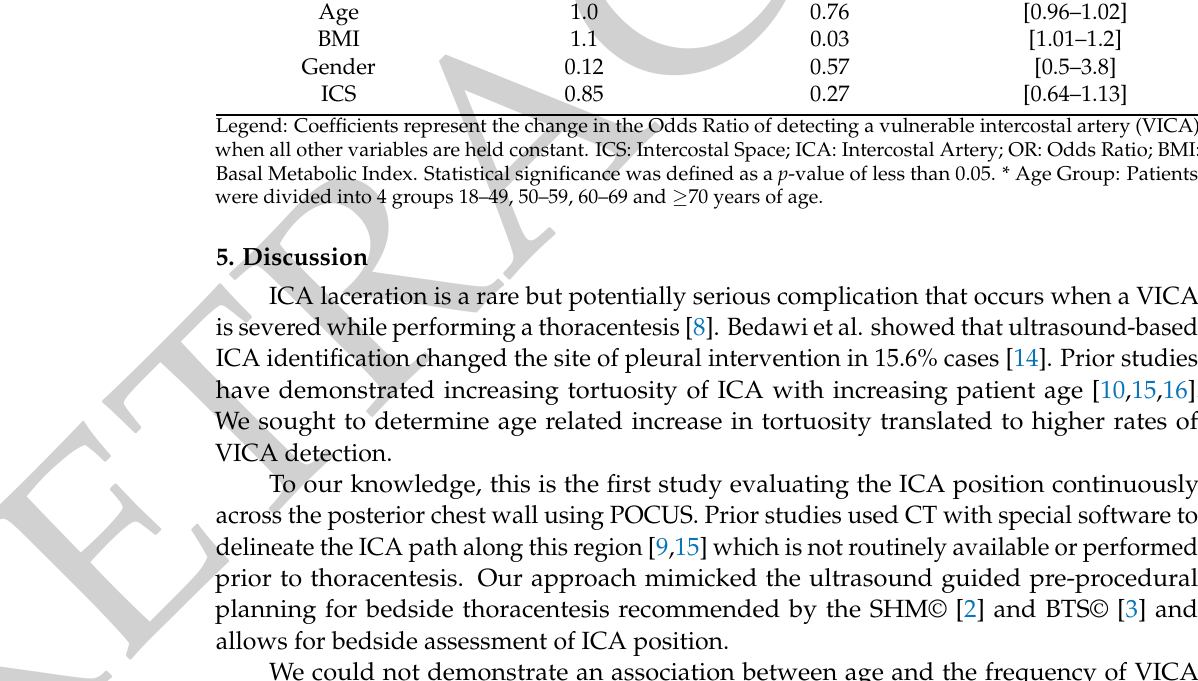
Table 1. Odds Ratio of detecting Vulnerable Intercostal Arteries. Variable